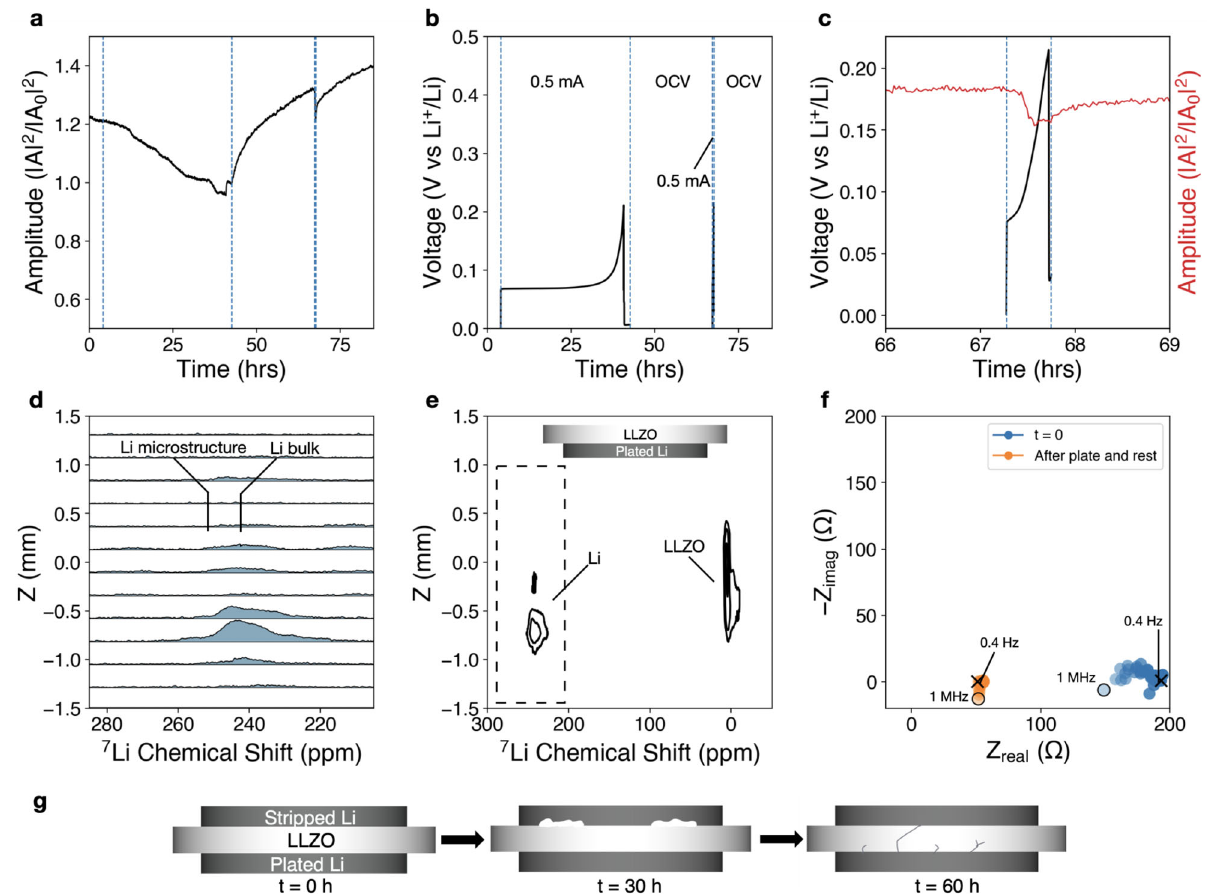
Fig. 5 Lithium metal – LLZO interface at 0.5mA/cm 2 . Polarization test of Li (s) – LLZO interface at 7.4 MPa stack pressure conducted in a Li/LLZO/Li cell. After a few hours of initial mechanical equilibration, 0.5 mA/cm 2 is applied galvanostatically, followed by a 25 h OCV rest step, a second polarization step in the same direction, and a second OCV rest step. a Normalized acoustic amplitude. b Voltage curve depicting two polarization steps and cell shorting at 0.2 V vs Li + /Li. Vertical guidelines are shown as a visual aid to delineate start and stop of galvanostatic current. c Zoomed in region of second polarization step showing a starting overpotential of ~75 mV but rapid polarization and another electrochemical short. d 1D slices of ex situ 7 Li CSI highlighting lithium metal signal between 200 and 280 ppm, as indicated by the dashed region in ( e ). e Ex situ 7 Li CSI contour plot showing small amounts of lithium penetration into the electrolyte, with the stripped lithium side (top) having fallen off after cell disassembly. f Nyquist plot from potentiostatic electrochemical impedance spectroscopy conducted during initial OCV, and after the electrochemical short. The open circle indicates the high-frequency start point (1 MHz), and the cross indicates the low-frequency end point (0.4 Hz). g Simpli fi ed cartoon illustration of interface behavior implied by the experimental data; not drawn to scale.